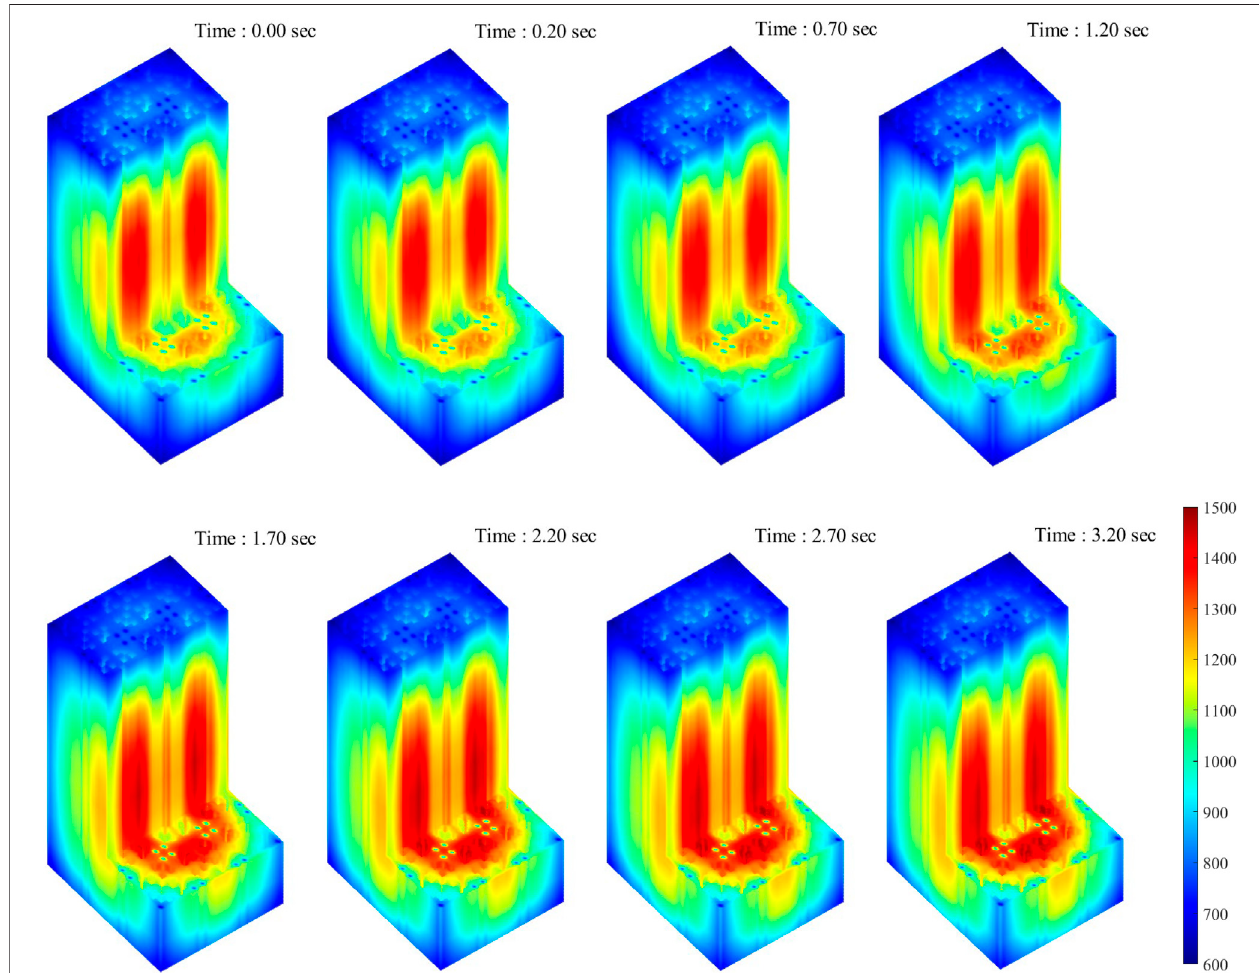
FIGURE 12 | Transient fuel pin temperature distribution of the mini-core